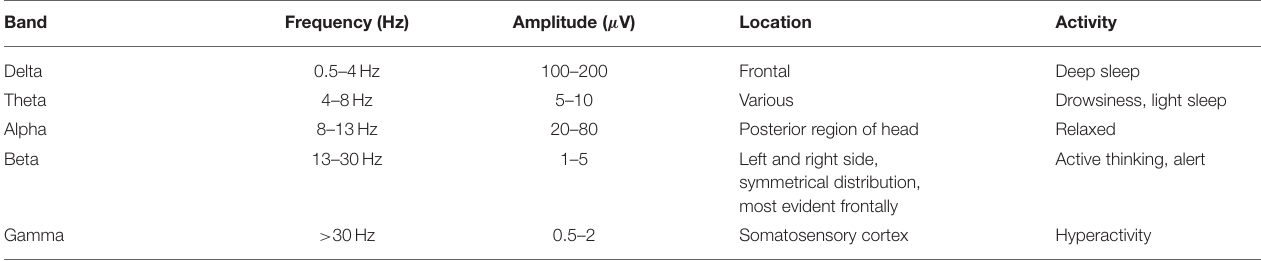
TABLE 1 | EEG frequency bands with